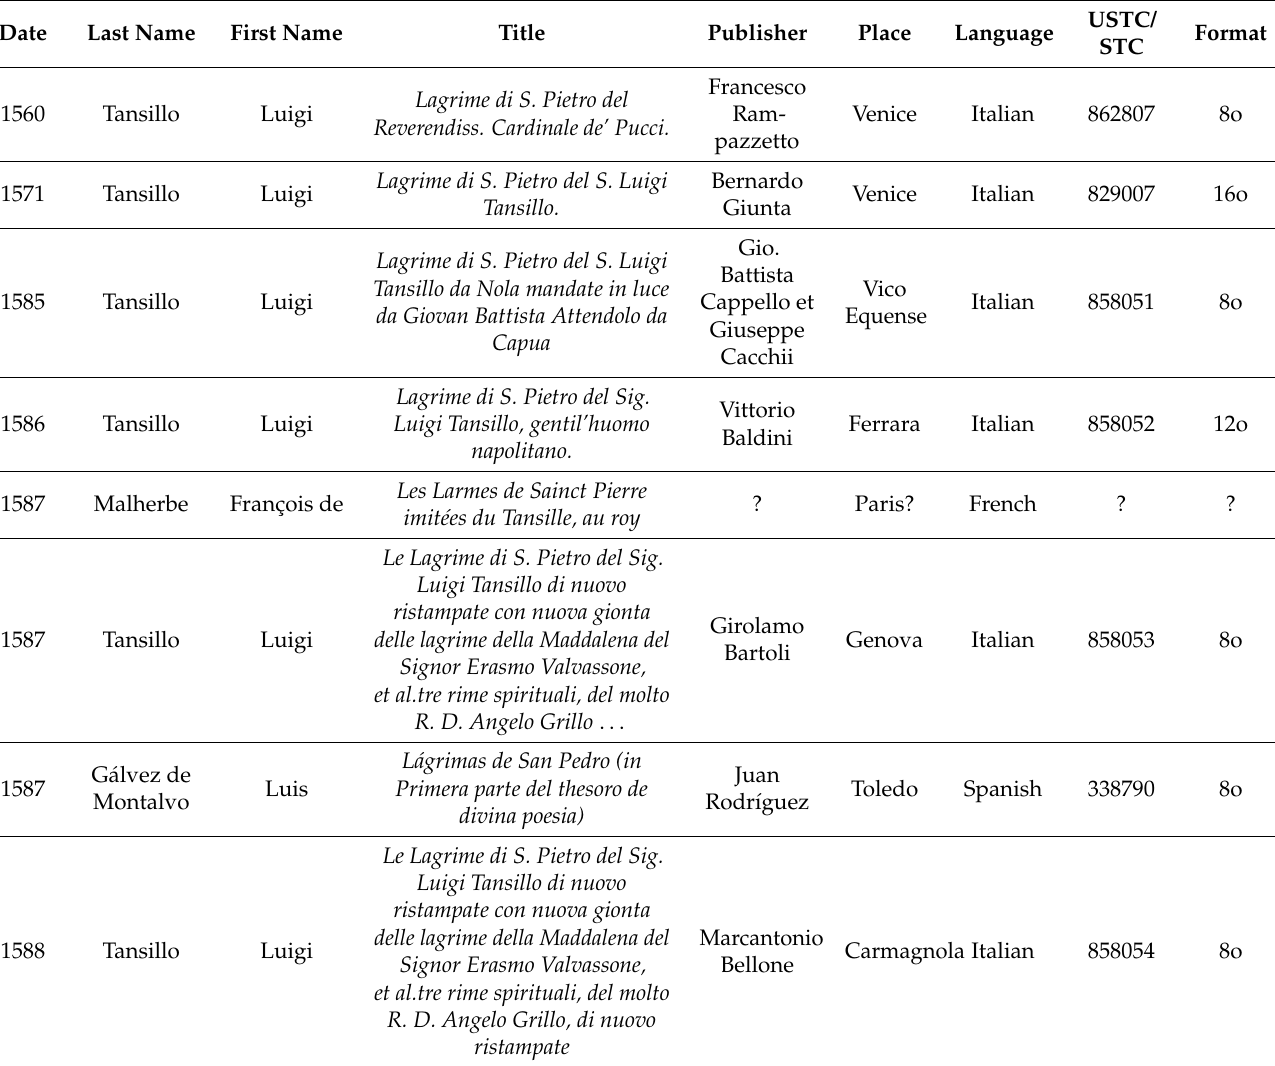
Table A1. List of Weeping Poems Published from 1550–1650 in Italy, Spain, France, Portugal, and